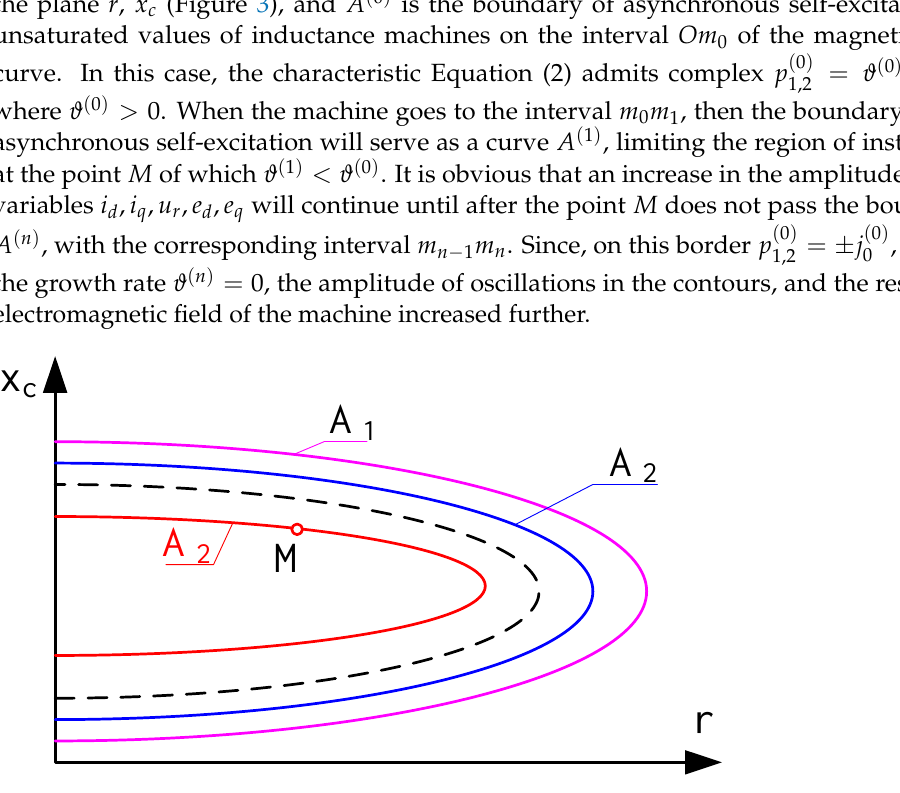
 and coefficient а at the 4 4